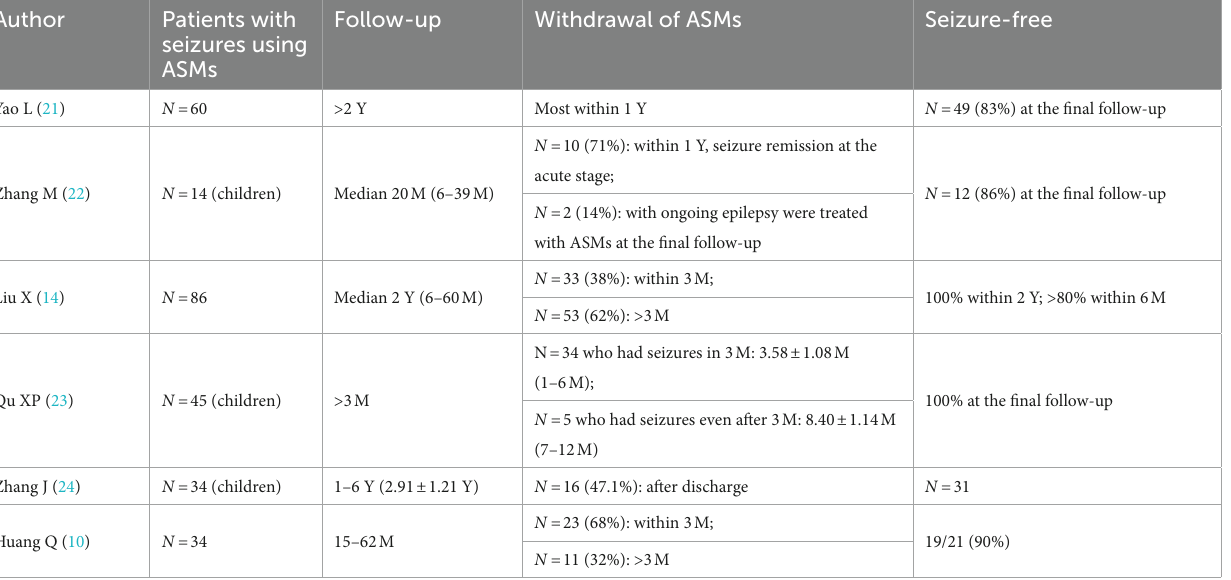
TABLE 4 Withdrawal of ASMs in anti-NMDAR